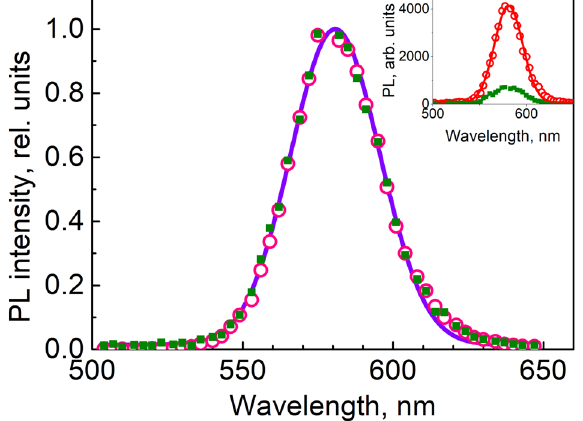
Figure 7. Local PL spectra of QDs in the regions of bright (open symbols) and dark (full symbols) stripes of the holographic structure with high and low concentrations of QDs, respectively (see the rectangular regions in Figure 4) normalized to the maximum values; the solid line represents the common Gaussian fit. Inset: the same PL spectra at the original intensity scale, with Gaussian fitting. The 3D image of the holographic grating (Figure 8) obtained using the LSM 710 confocal microscope by scanning along three coordinates with a 405 nm laser beam revealed no observable PL inhomogeneities that would represent microscale aggregates of QDs